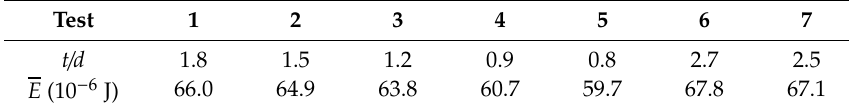
Table 3. E of specimens with various t / d.